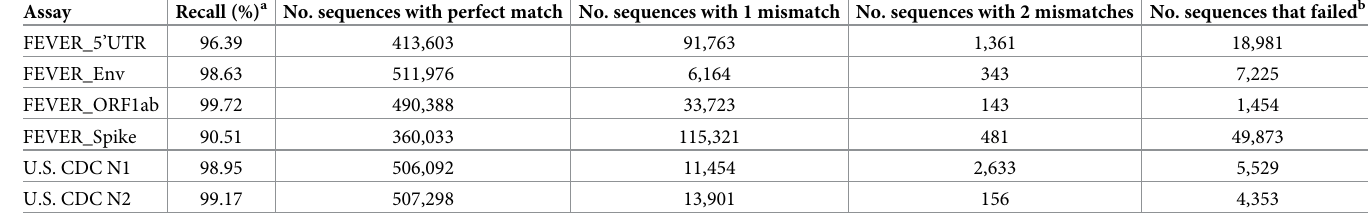
Table 2. In silico inclusivity test against SARS-CoV-2